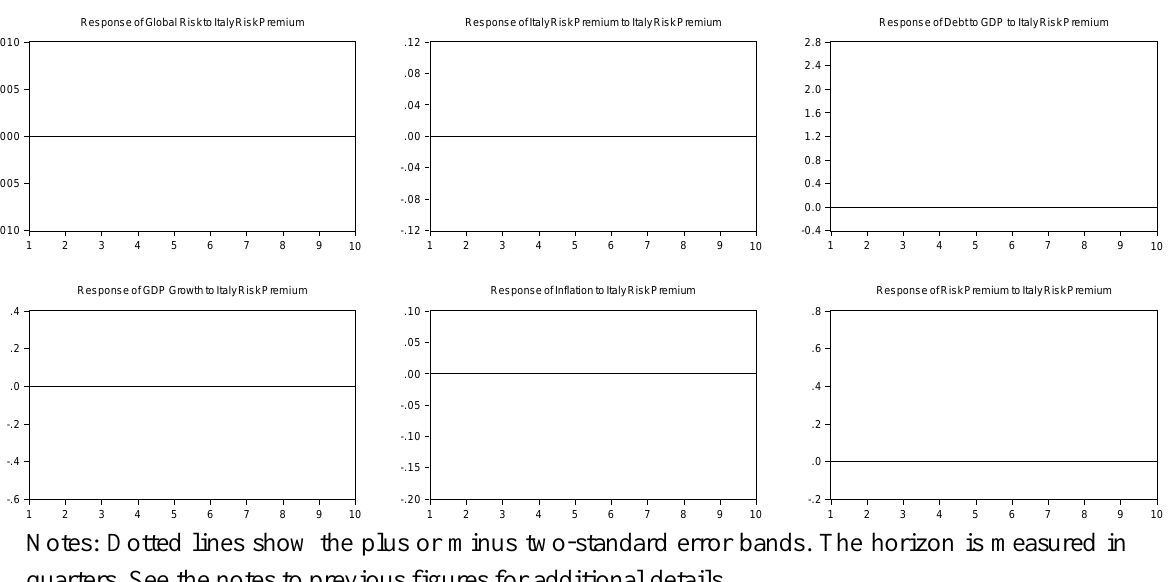
Figure 10. Response of EMU countries to a shock to Italy’s risk premium during the crisis: